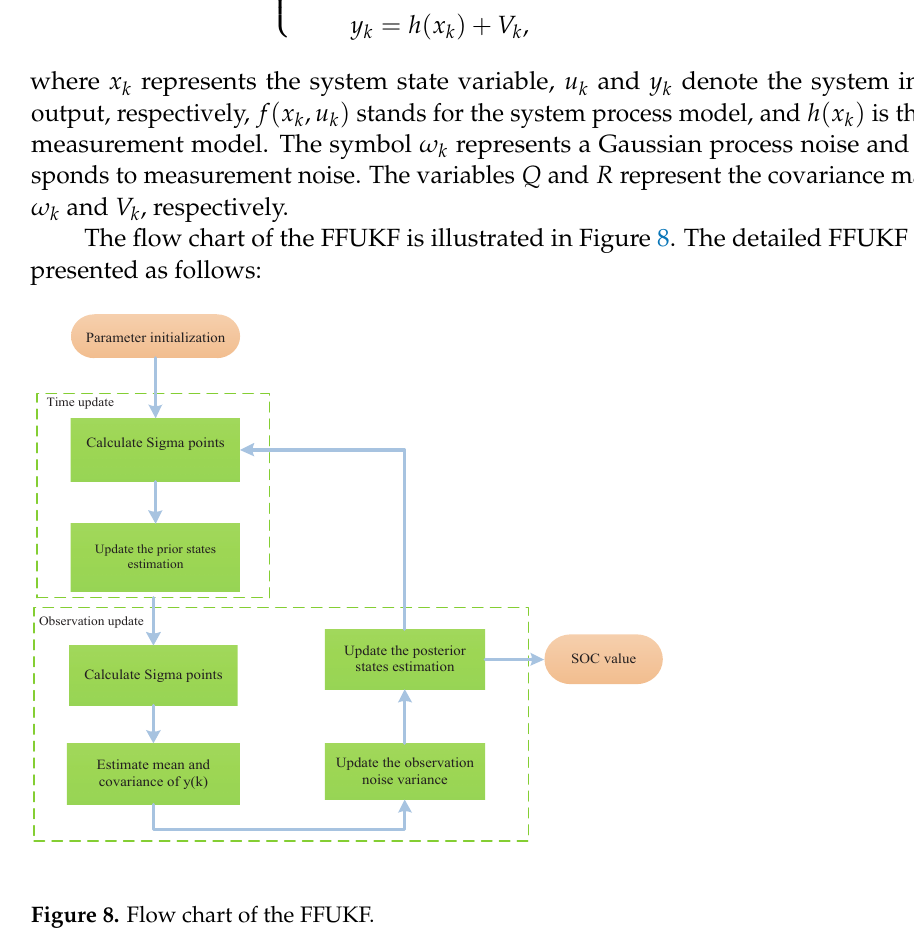
Figure 8. Flow chart of the